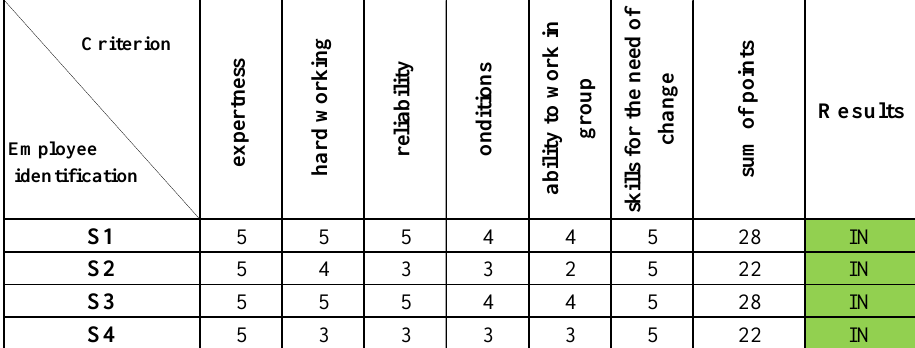
Table 7 – Evaluation of criteria by Head of warehouse no.